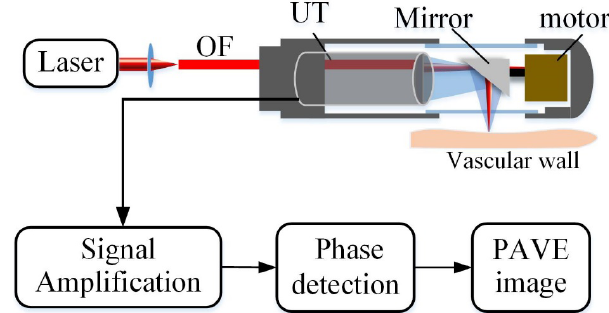
Fig. 10. Schematic of the experimental setup for PAVEE; MO: microscopic objective, UT: ultrasound transducer and OF: optical